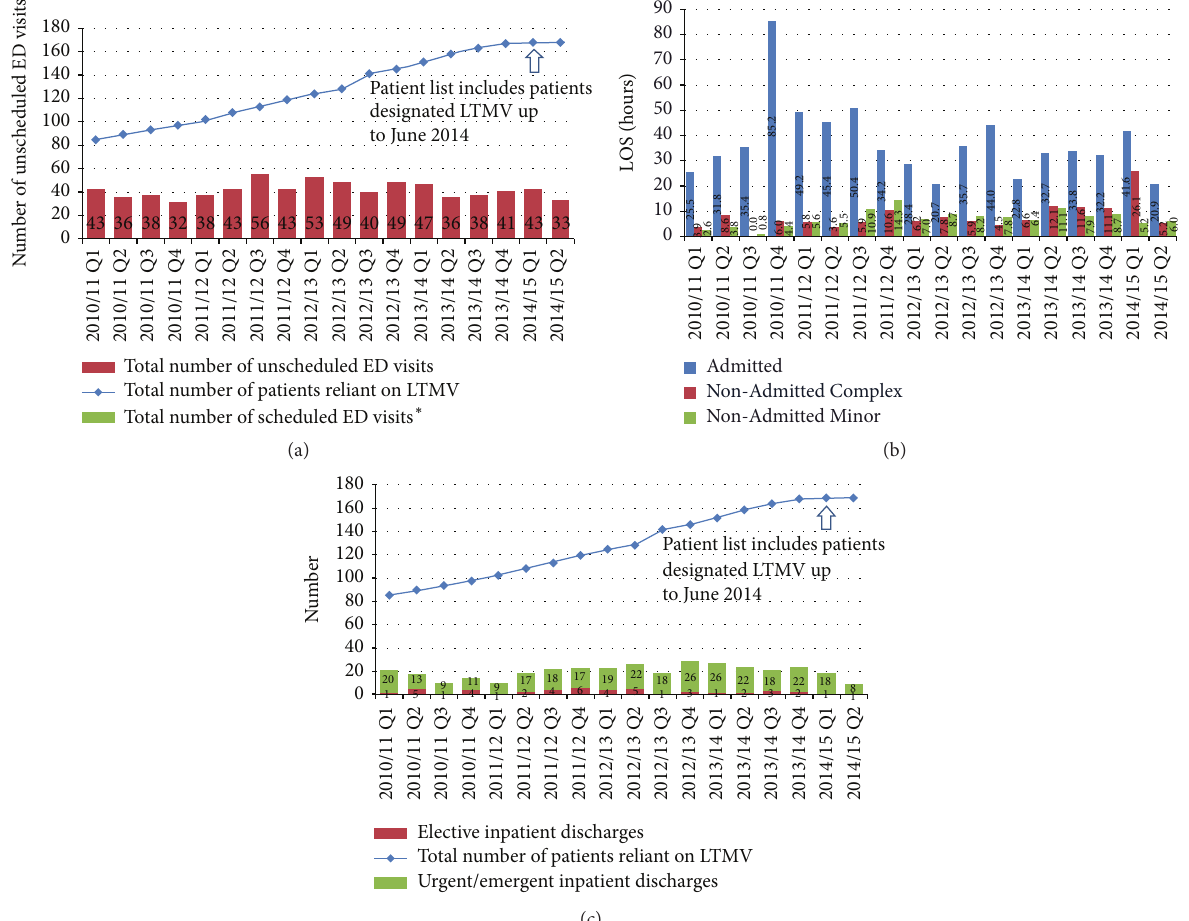
Figure3:(a)Emergencydepartmentutilization(EDvisits).TotalnumberofEDvisitsforallpatientsreliantonLTMV,byEDvisittype. ∗ Note: from Q1 2010/11 until present, there have been no scheduled ED visits within this cohort. (b) Emergency department utilization (ED LOS). Length of stay (LOS) in ED (hours) for patients reliant on LTMV, 90th percentile. Note: the data above includes ED LOS in any facility that a LTMV patient visited. For comparison, in Q2 2014/15, Ontario, as a whole, had an Admitted LOS of 29.5 hours, a Non-Admitted Complex LOS of 6.8 hours, and a Non-Admitted Minor LOS of 4.0 hours. (c) Acute inpatient utilization (hospital discharges). Total number of acute inpatient discharges for all patients reliant on LTMV, by inpatient visit